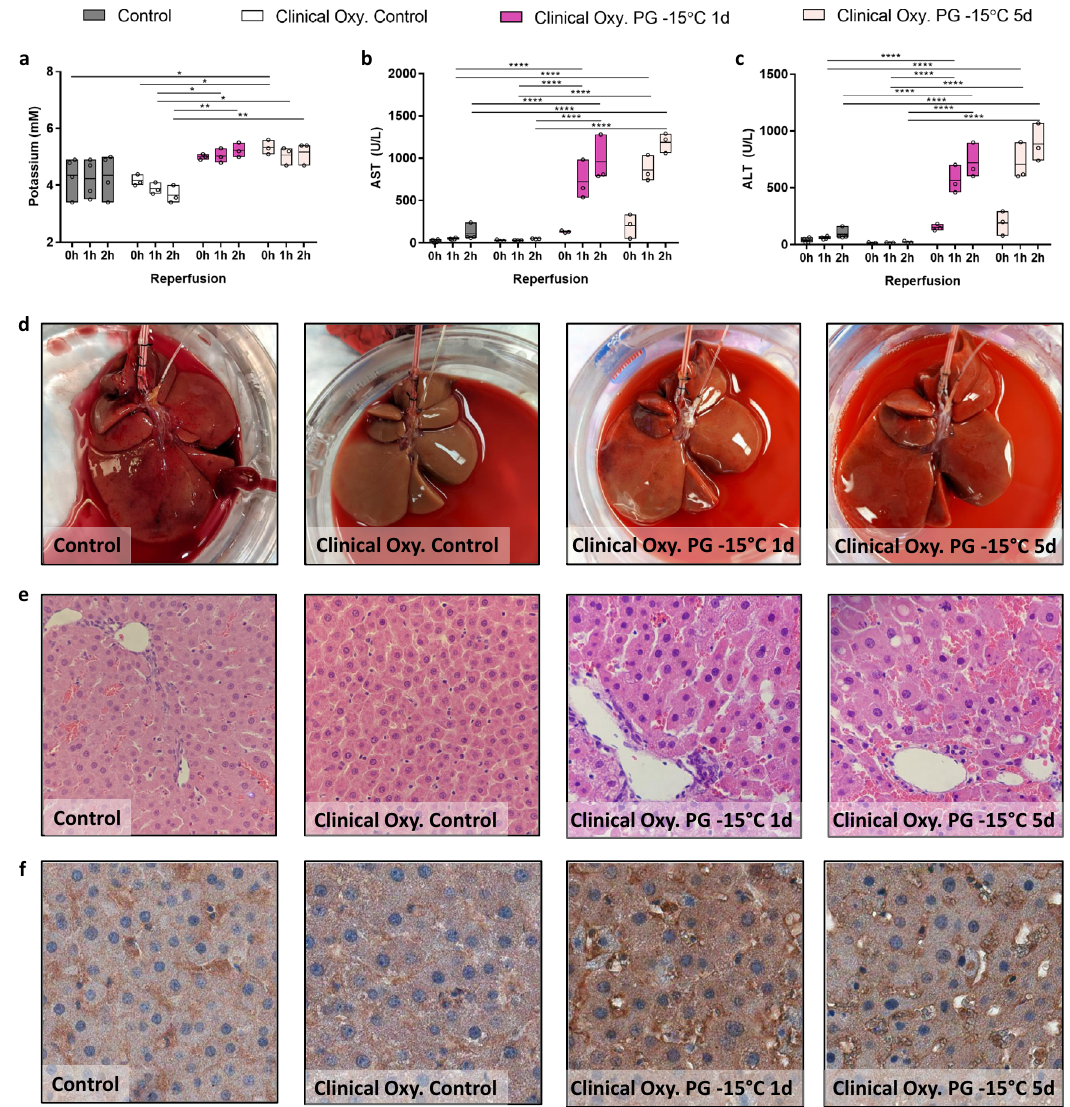
Fig. 5 Effect of a clinical grade oxygenator on hepatocellular injury and microscopic tissue structure after partial freezing with propylene glycol at − 15 °C for 1 and 5 days. a Potassium concentration in the IVC. b Aspartate aminotransferase concentration (AST) in the IVC. c Alanine aminotransferase concentration (ALT) in the IVC. d Photos of the livers at the end of simulated transplantation. e Light microscopy images of parenchymal liver wedges